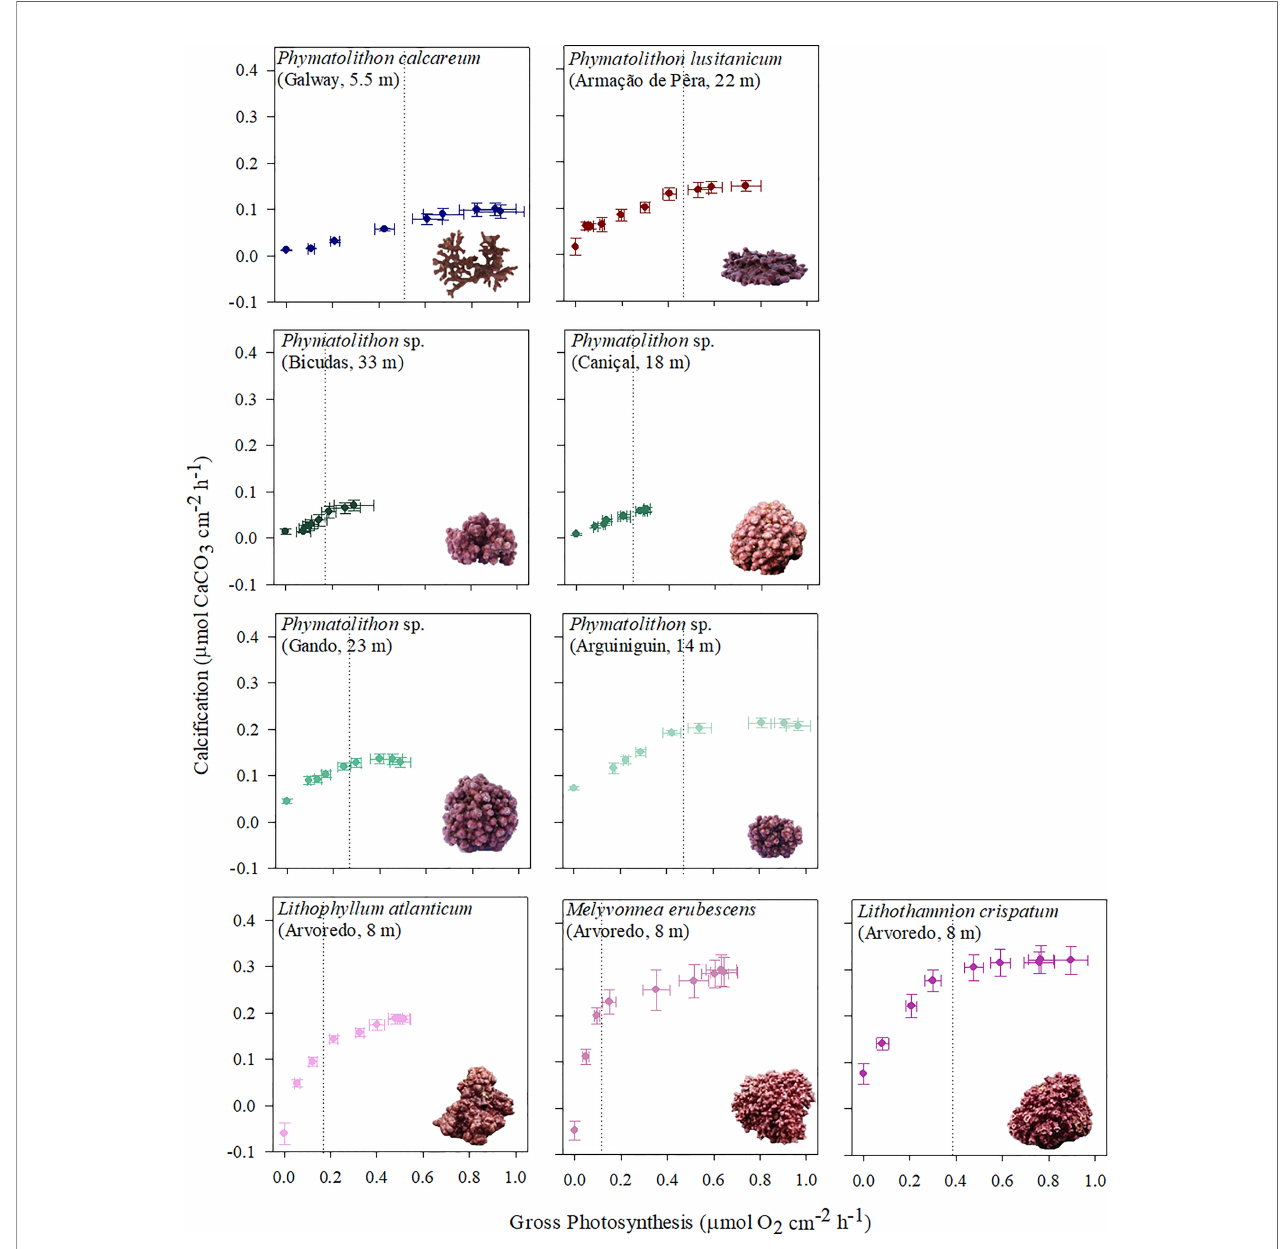
FIGURE 2 | Photosynthesis-calci fi cation relationships for Atlantic rhodolith species (location, depth), obtained from light curves (dotted line indicates E k ). Data points represent mean ± SE